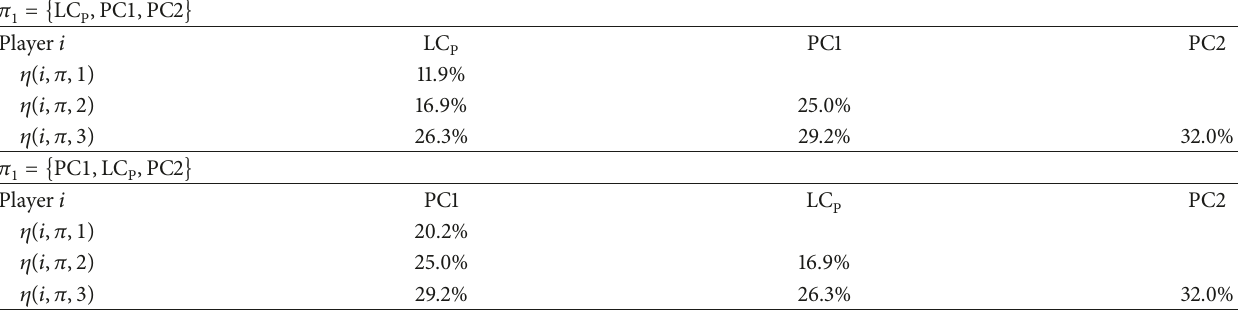
Table 11: Pickup coalition sequences based on SMP.